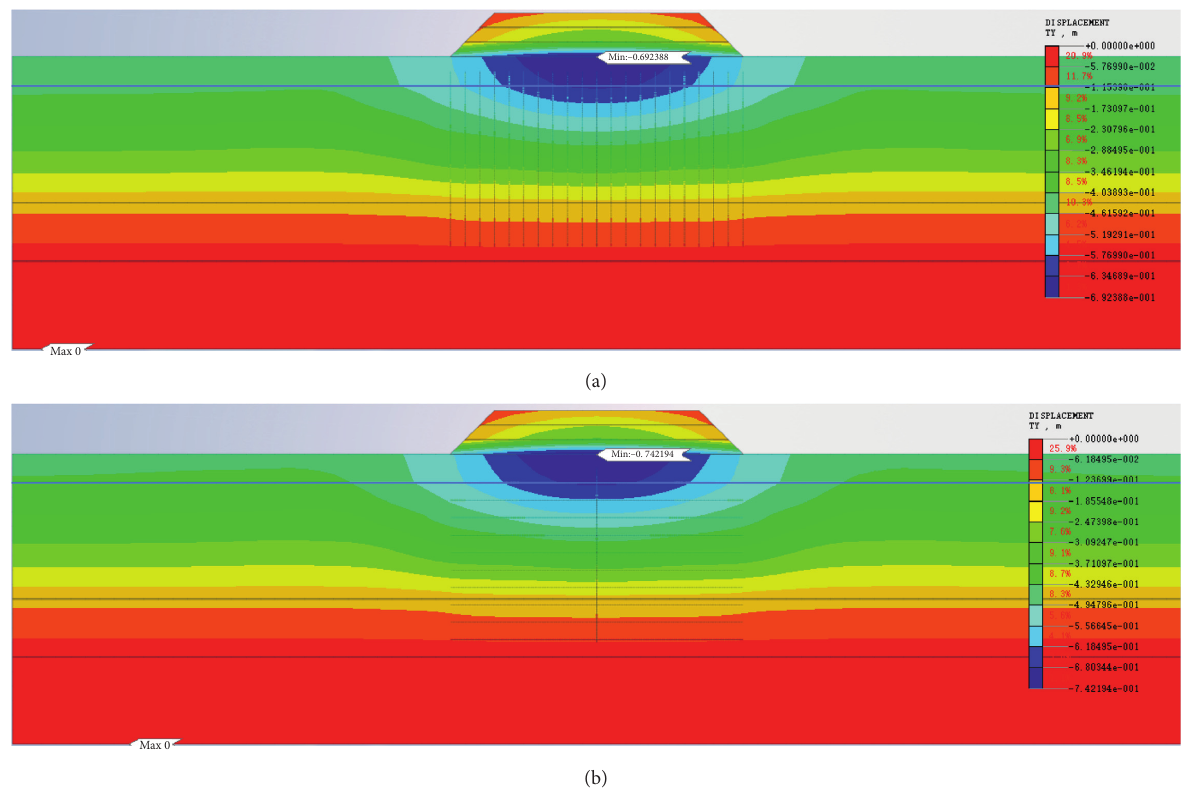
Figure 3: Vertical settlement nephogram of finite element: (a) vertical drainage and (b) horizontal drainage.